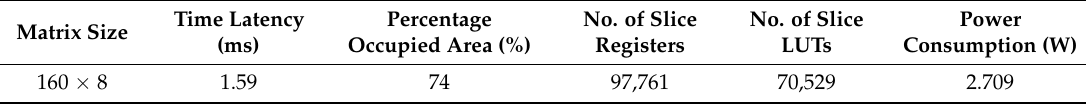
Table 3. Kernel function implementation results for Virtex 5